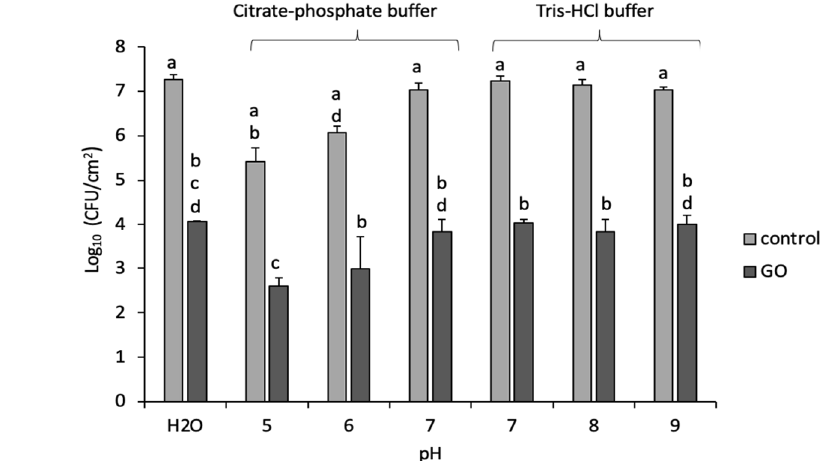
Figure 2. Impact of different constant pH values on P. putida biofilm ( a ) The viability of biofilm after exposure to different pH values (pre-treatment). ( b ) The viability of biofilm after the exposure to constant pH and incubation with either deionized water (control) or 85 mg/mL of GO for 24 h (post-treatment). Mean values with different letters are significantly different ( p < 0.05). Similar letters are non-significantly different. The data were analyzed with one-way ANOVA. Table 3. Differences in log 10 CFU/cm 2 viability between pre-treatment and GO; control and GO. H 2 O